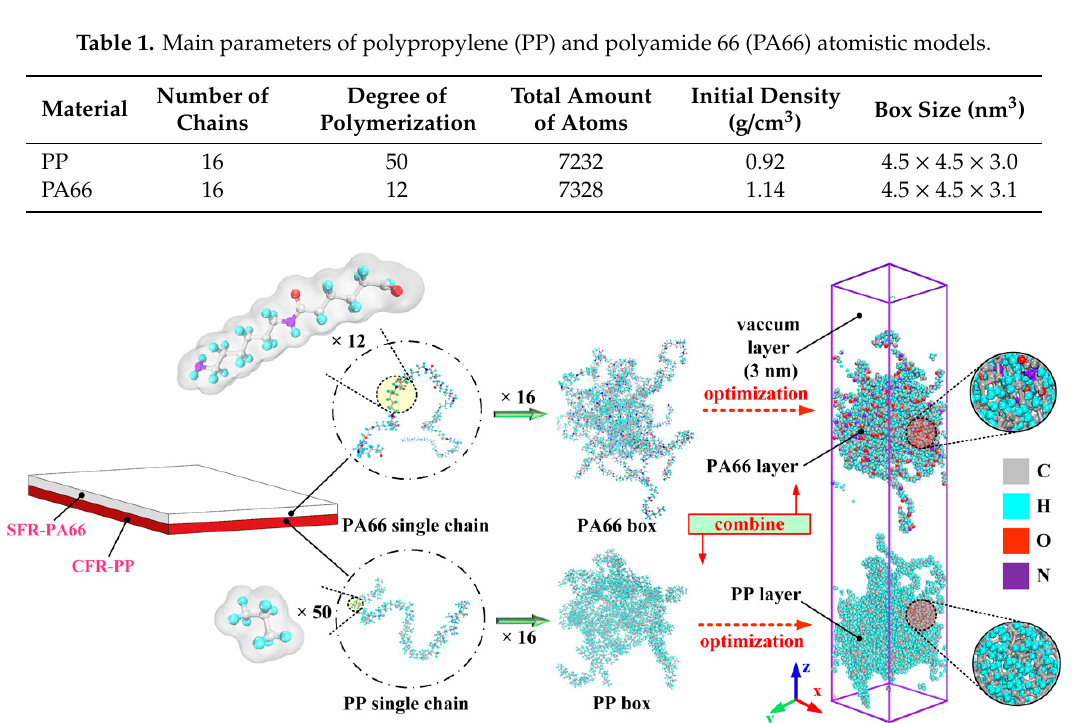
Table 1. Main parameters of polypropylene (PP) and polyamide 66 (PA66) atomistic models.